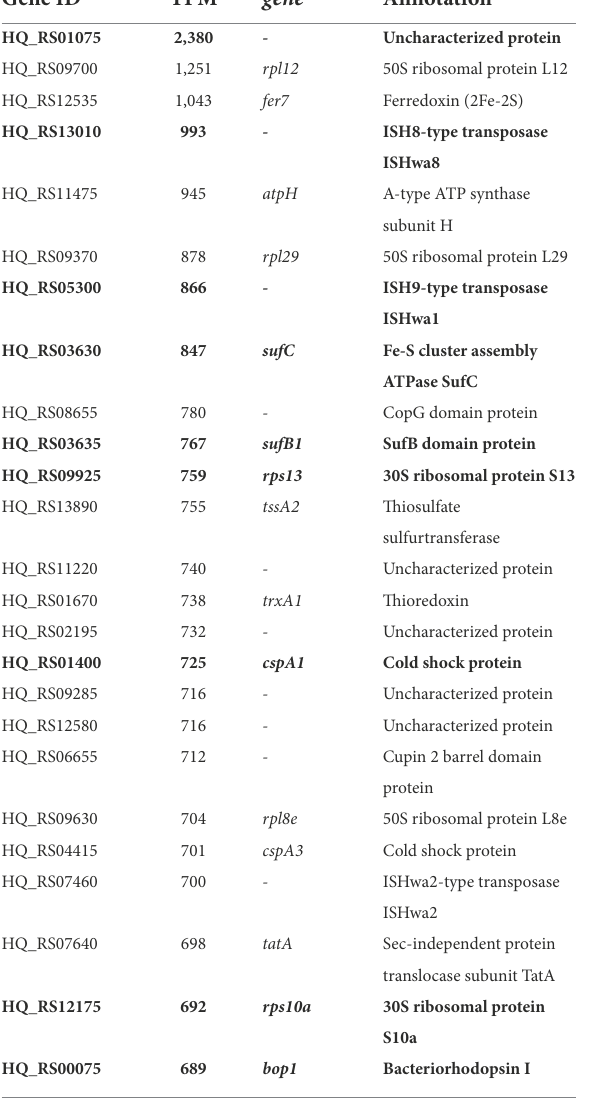
TABLE 2 Top 25 of highest expressed protein coding genes in the summer population of Hqr. walsbyi HBSQ001.